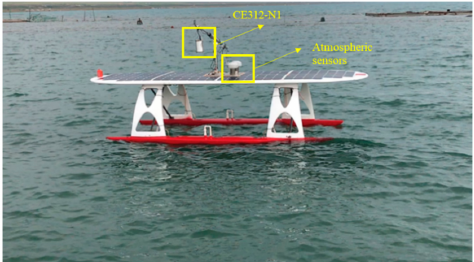
Figure 2. Unmanned surface vehicle with atmospheric sensors and a CE312-N1 used in the vicarious radiometric calibration.